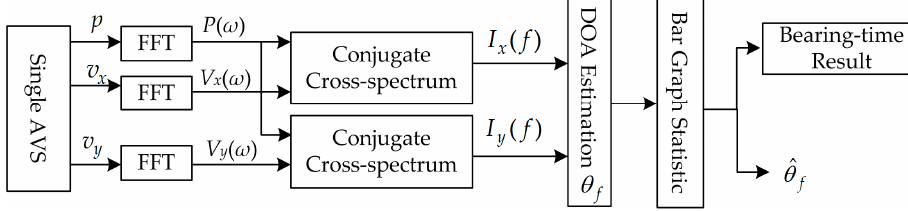
Figure 2. Principle chart of bar graph approach based on complex acoustic intensity measurements.